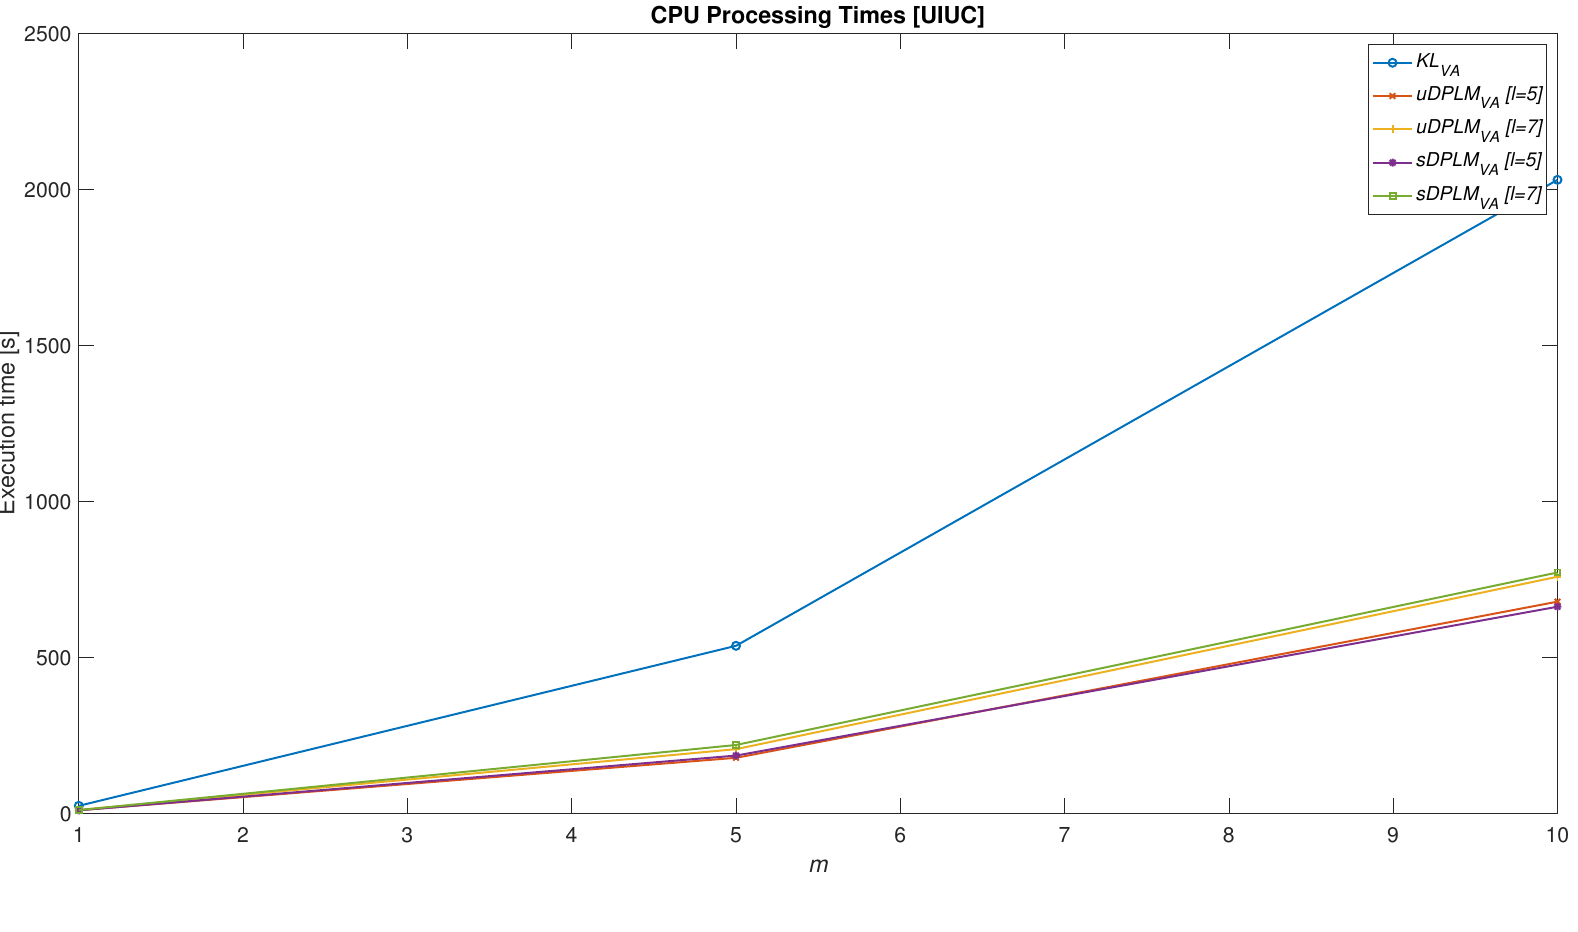
Figure 4. CPU processing times for the UIUC database, DPLM VA vs. KL VA